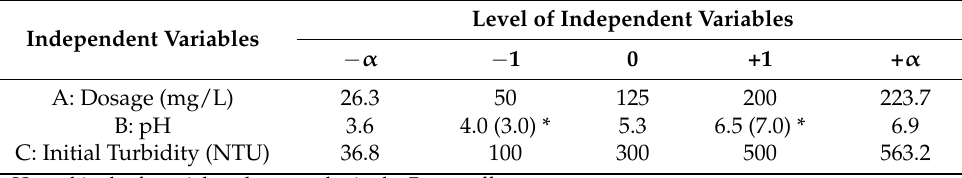
Table 2. Coded and real levels of independent variables in the CCD.